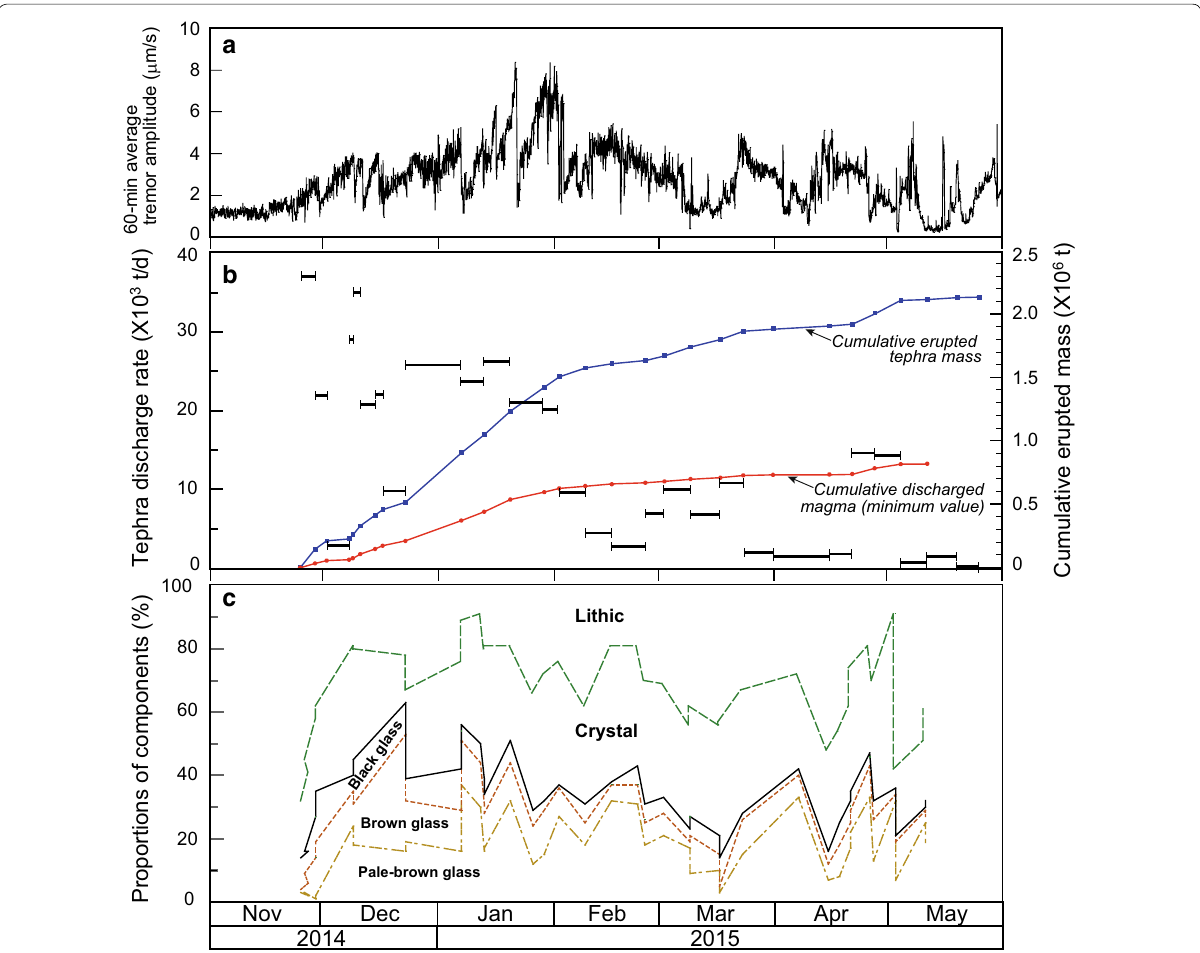
Fig. 5 Temporal variations in 60-min average amplitude of volcanic tremor ( a ), tephra discharge rate, cumulative erupted mass ( b ) and proportion of ash components ( c ). The volcanic tremor (N-S component) was observed at about 0.7 km WNW of the Nakadake first crater by the Japan Meteorological Agency (Fukuoka District Meteorological Observatory 2016). The cumulative discharged magma was estimated based on proportions of glass